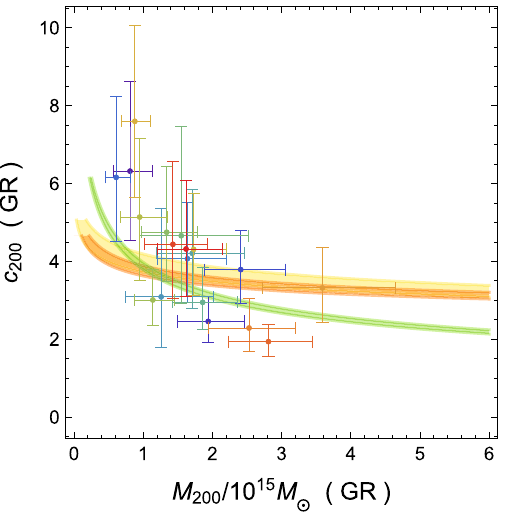
Fig. 7 Concentrations and masses of CLASH clusters: comparison between our work and c – M relations from the literature. Yellow band: c – M relation from [76]; orange band: c – M relation from [77]; green